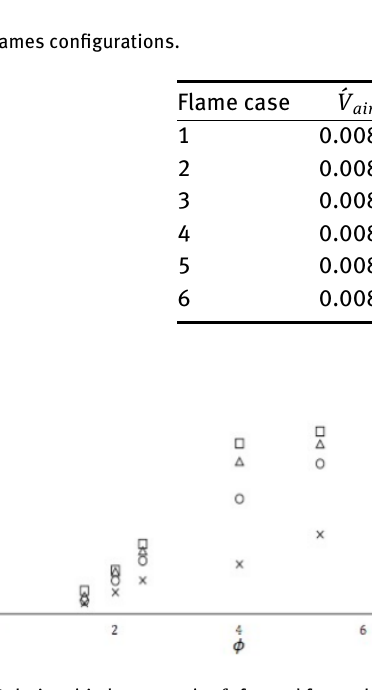
Figure 3: Relationship between the f ν formed for each ϕ used. The following symbols represent the measuring height from the base of the flame: (x) of 5 mm, (o) of 10 mm, ( (cid:52) ) of 15 mm and ( (cid:3) ) of 20